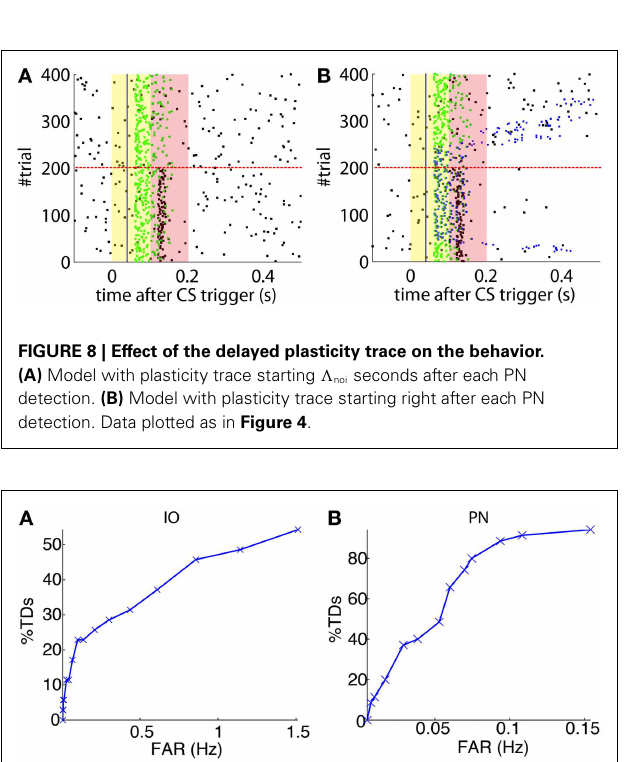
FIGURE 9 | Event detection performance for the recording sites. ROC curves for the IO (A) and the PN (B) event